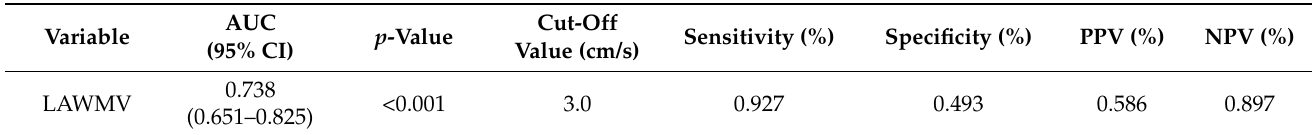
Table 6. The area under the curve analysis for LAWMV predicting sinus rhythm maintenance at 12 months after